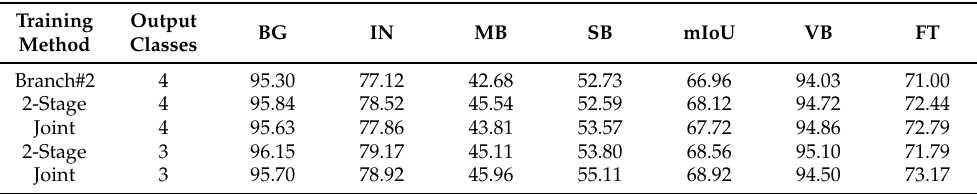
Table 8. Results of different training methods and output methods. “Branch#2” stands for training the severity segmentation branch only.